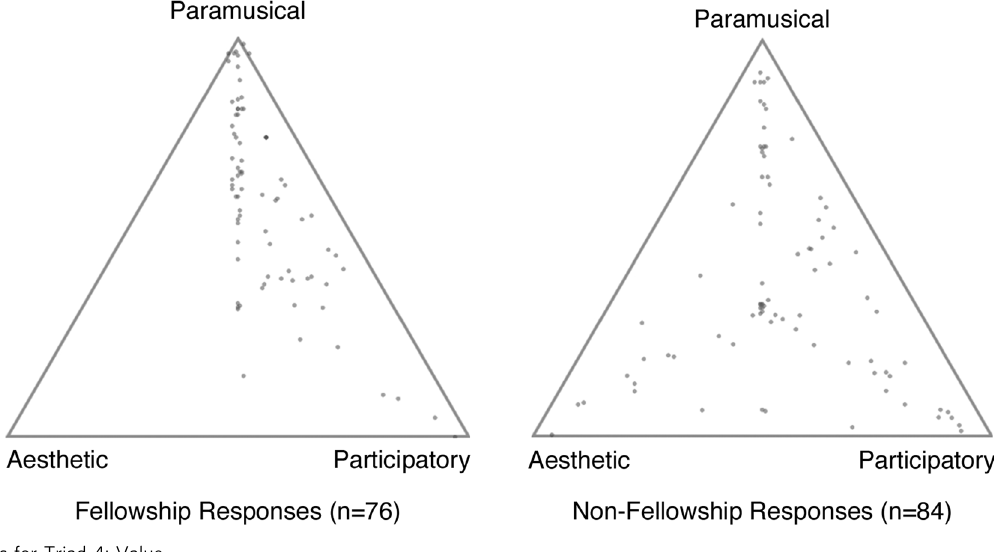
Fig. 5 Responses for Triad 4: